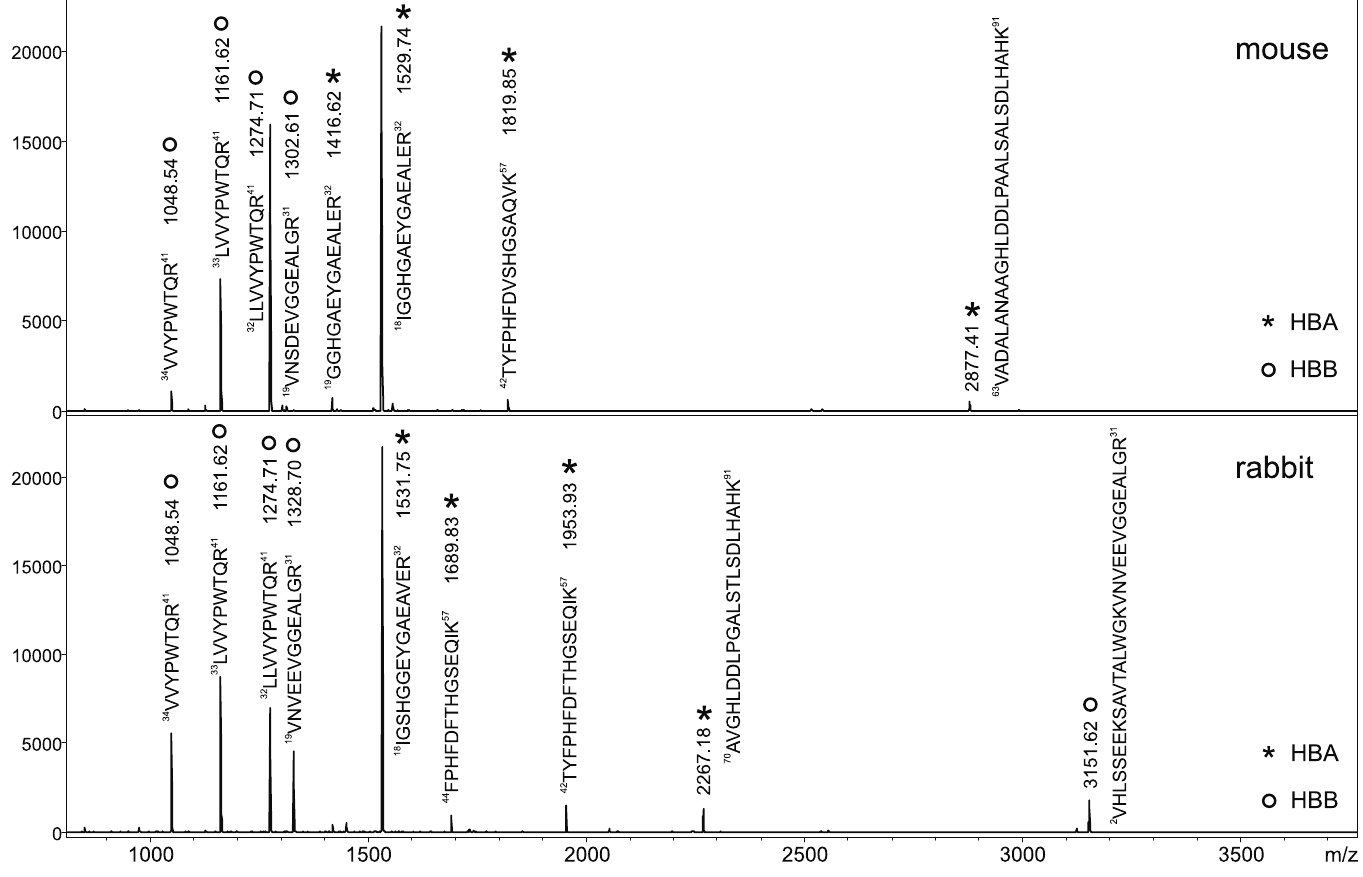
Fig 3. MALDI-TOF peptide mass maps measured after trypsin digestion of homogenized abdomens of P . perniciosus fed on SKH1 mouse and rabbit. The peaks are labelled by corresponding peptide sequences (see Table 1) of host HBA (asterisks) and HBB (circles). In comparison to the Table 1 a double mutation in the peptide AA 63–91 was detected for SKH1 mouse used in this study as a blood source. The bloodfed females were collected 12 h